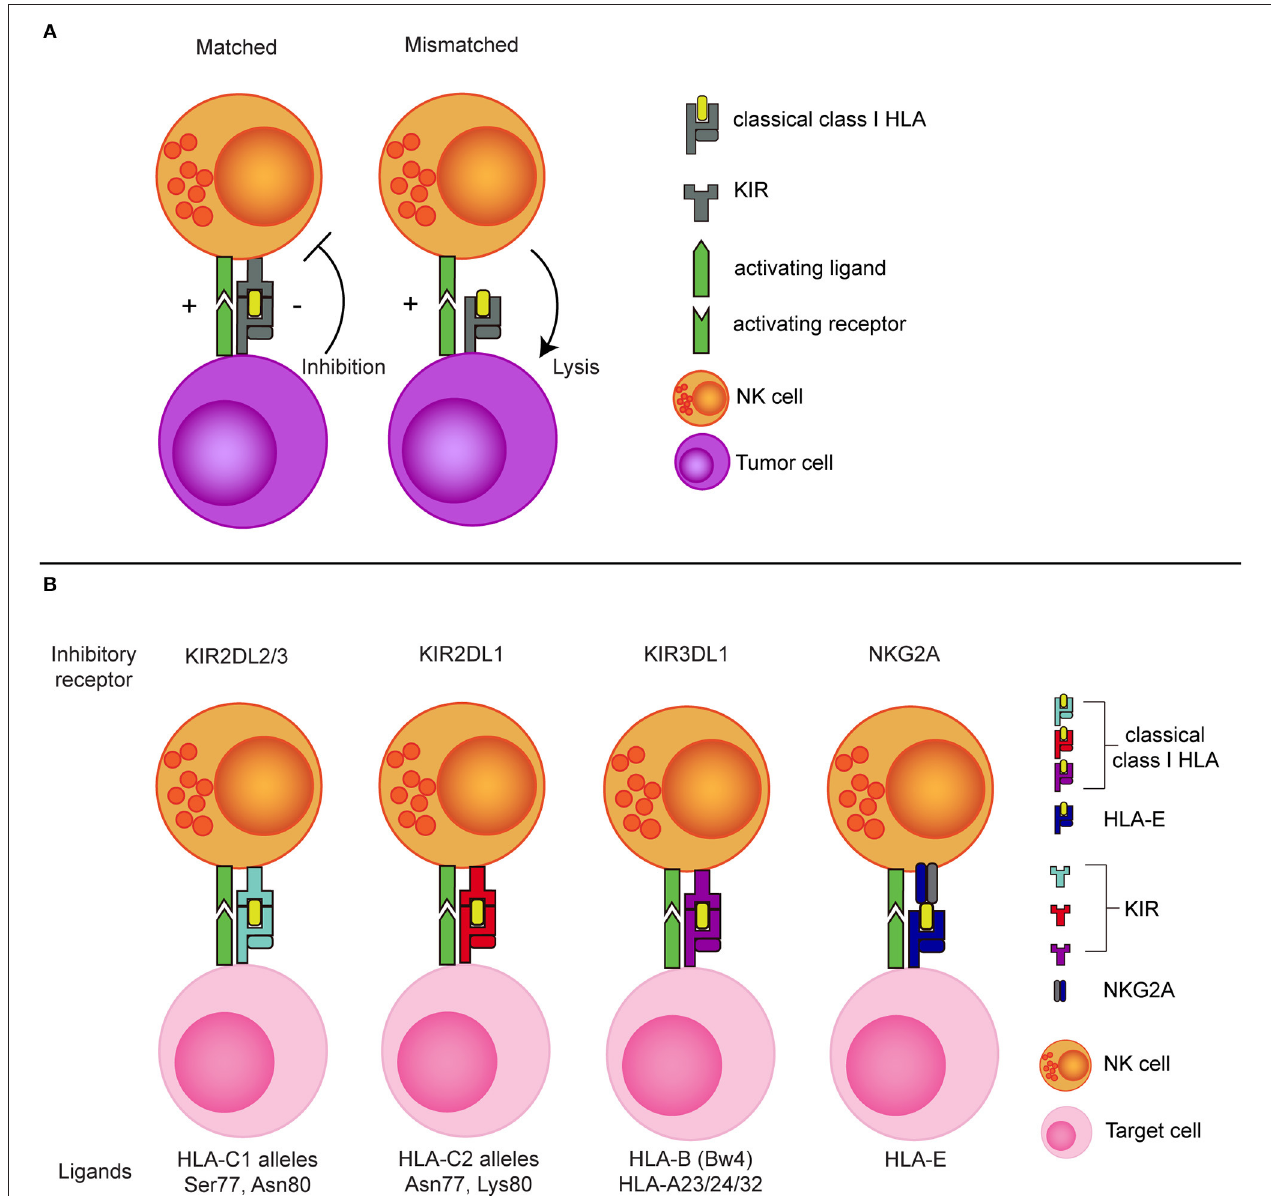
FIGURE 1 | The concept of NK cell alloreactivity concept based on interaction with HLA class I. (A) When an inhibitory KIR binds to a “matched” classical class I HLA molecule, an NK cell receives inhibitory signal from this interaction. In the absence of the corresponding class I HLA molecule (mismatched situation), the inhibitory signal is absent, resulting in a reduced NK cell activation threshold. (B) Inhibitory KIRs and NKG2A and their corresponding class I HLA molecules. KIR, Killer immunoglobulin-like receptor; HLA, Human leukocyte antigen; Ser, Serine; Asn, Aspargine; Lys,